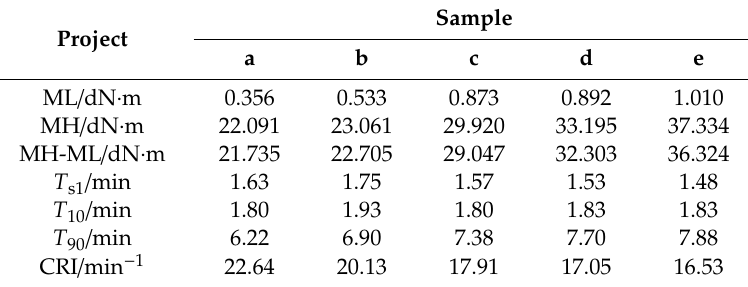
Table 2. Curing characteristics of SSC@NR compounds.